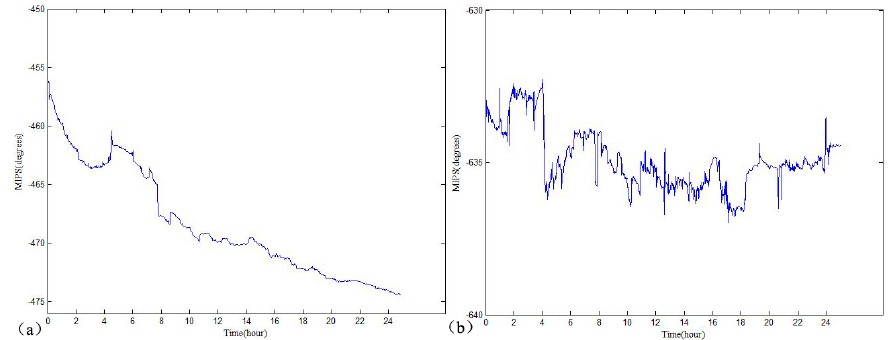
Figure 5. ( a ) The 24 h MIPS results of the No. 3 rabbit in the experiment group; ( b ) 24 h MIPS results of the No. 12 rabbit in the control group.